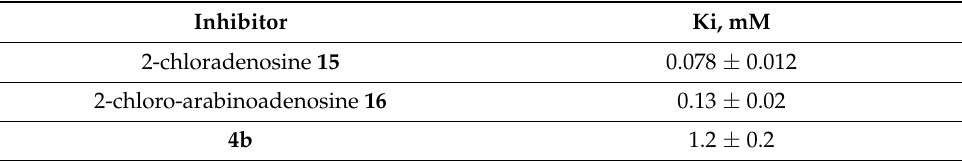
Table 5. Inhibition of E. coli adenosine